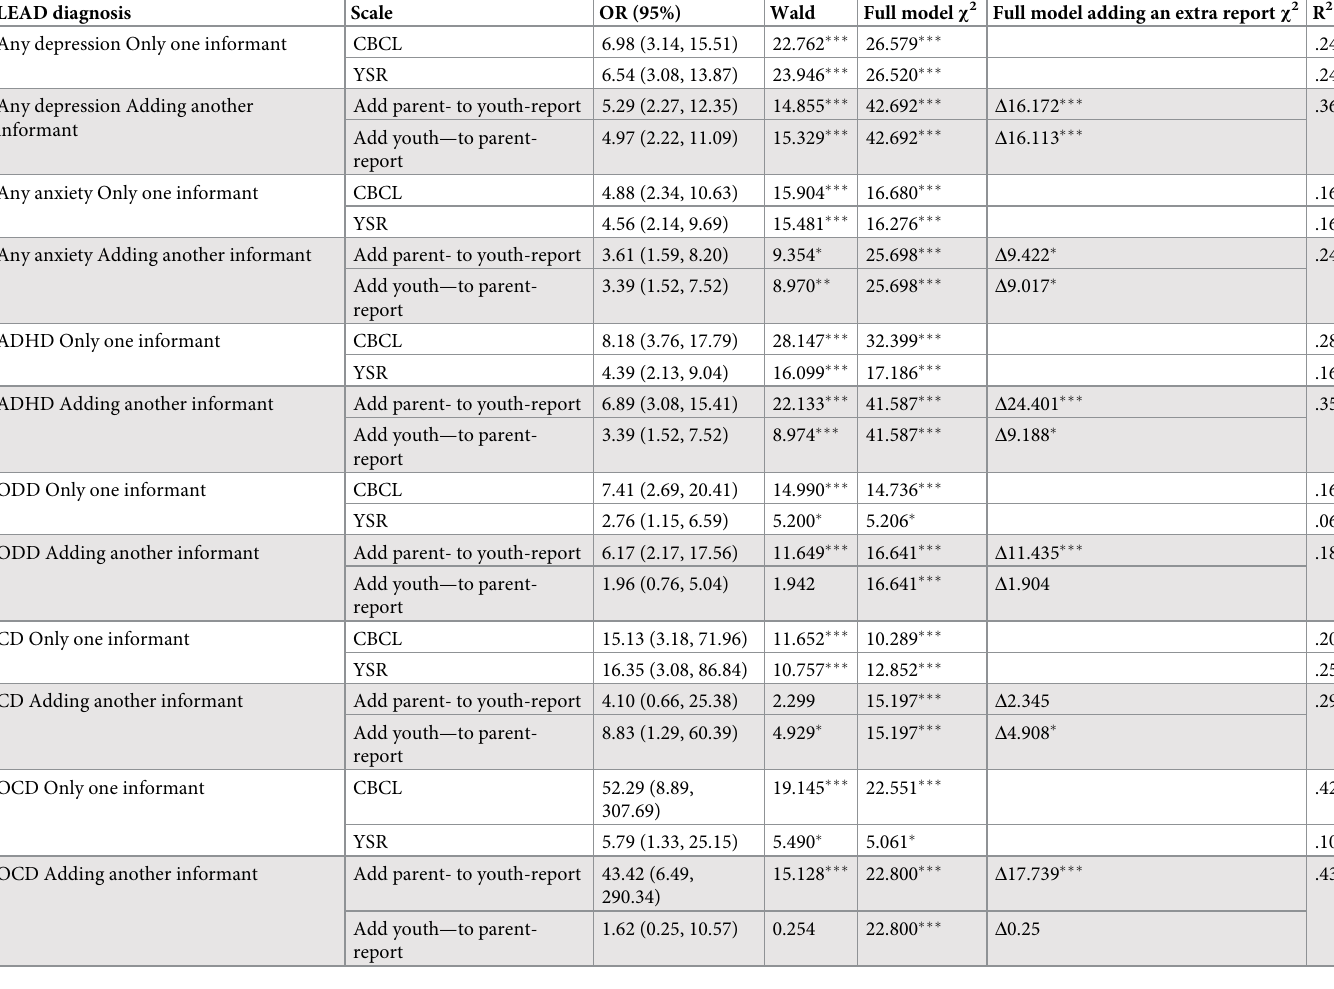
Table 5. Sequential logistic regression to test the effects of child and parent report on the DOS scales (using the most optimal cut-off scores) for the prediction of LEAD diagnoses. LEAD